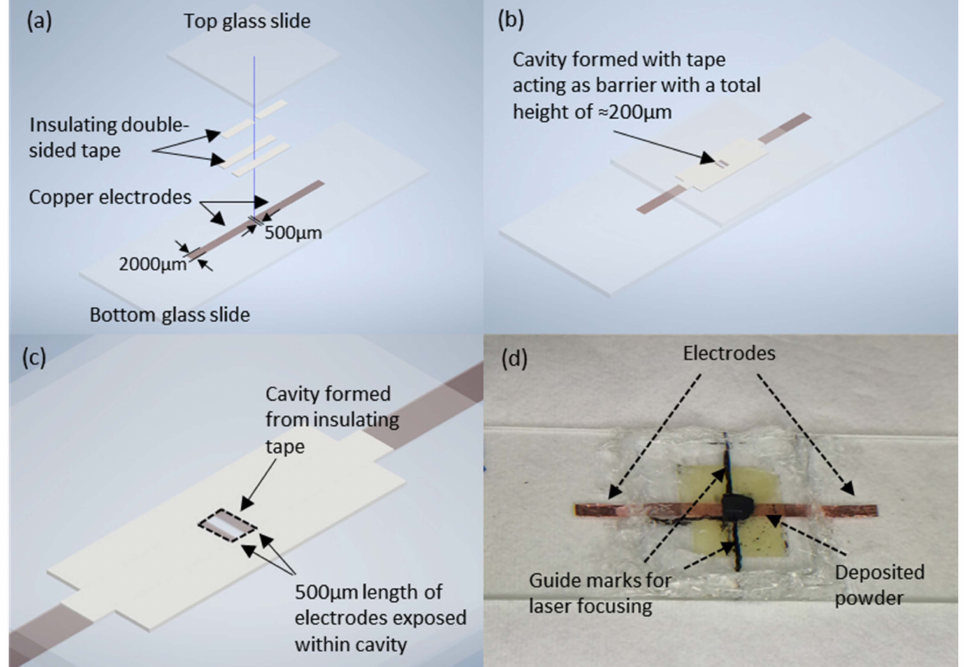
Figure 1. ( a ) Complete schematic of sample holder. ( b ) Schematic of sample holder with components placed together. ( c ) Magnified schematic drawing highlighting formation of cavity. ( d ) Optical image of sample with deposited carbon powder. Markings assist in the focusing of the